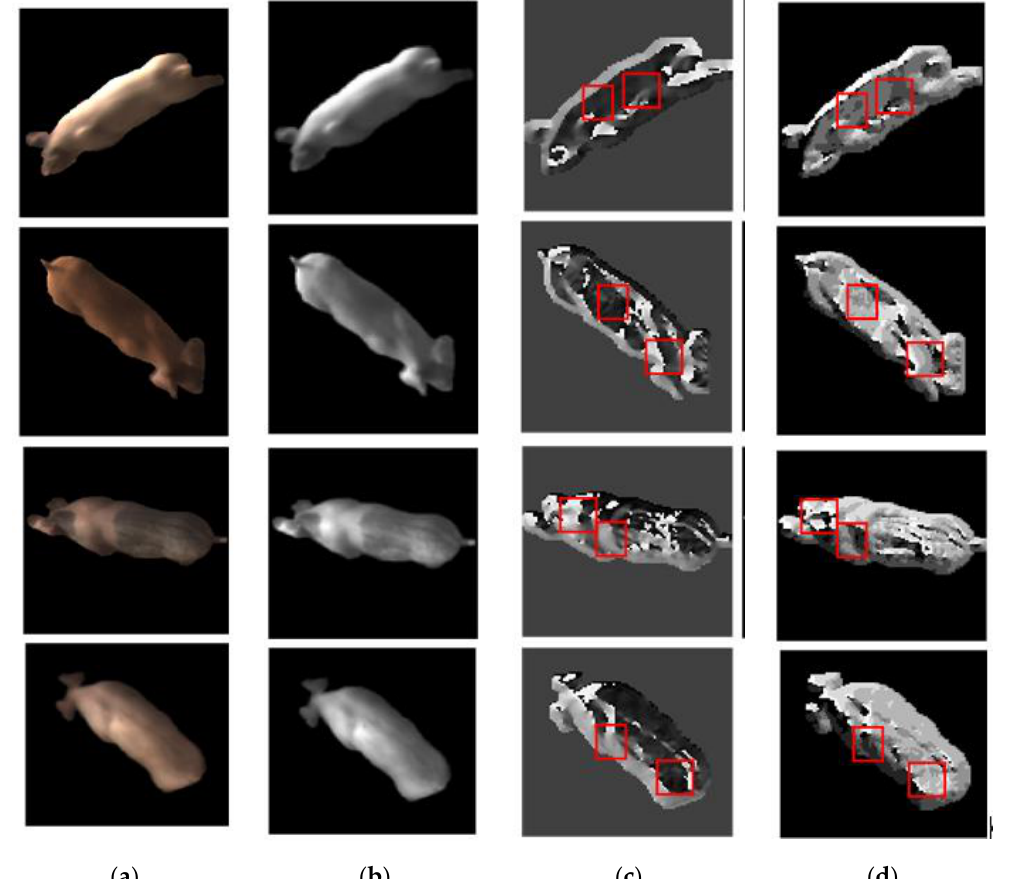
Figure 7. Directional images of Weber local descriptor (WLD) and the proposed WTLD. ( a ) Original images; ( b ) gray images; ( c ) directional images of WLD; ( d ) directional images of the proposed WTLD.